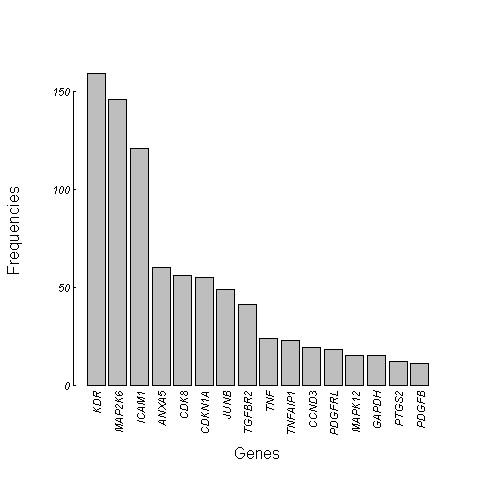
Histogram of Gene Usage Frequencies. Examination of the gene usage frequencies among the best of 220 rules drawn from 20 runs of 11 folds showed a strong preference for the KDR, MAP2K6 and ICAM1 genes which were also components of some of the major gene expression motifs. Rules created using only the top three genes showed a comparatively better performance, indicating their importance in the genesis of nodal metastasis.